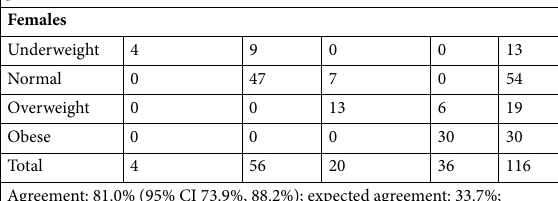
Table 4. Contingency tables featuring degrees of agreement between weight classifications based on the BMIs computed using the Quetelet index popularized by keys (BMI K ) and modified formula proposed by Trefethen (BMI T ), stratified by sex.